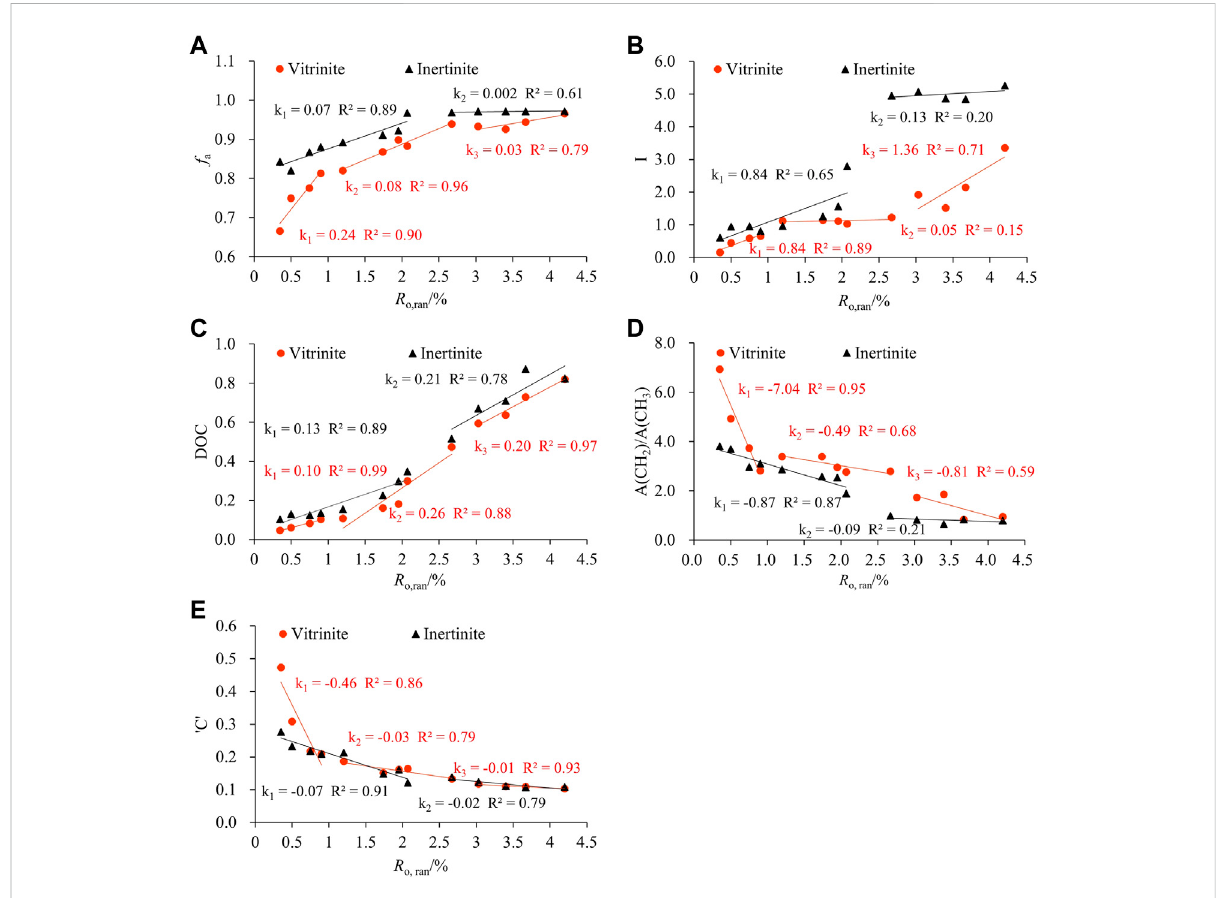
FIGURE 6 Relationships between R o ,ran and FTIR structure